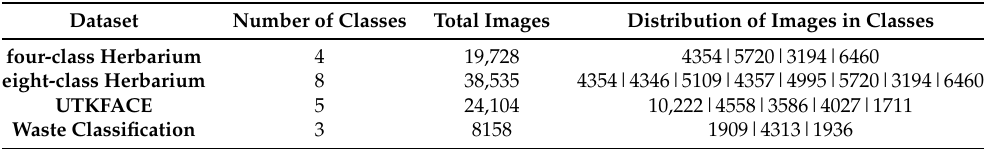
Table 1. Summary description of the datasets used in the experiments.